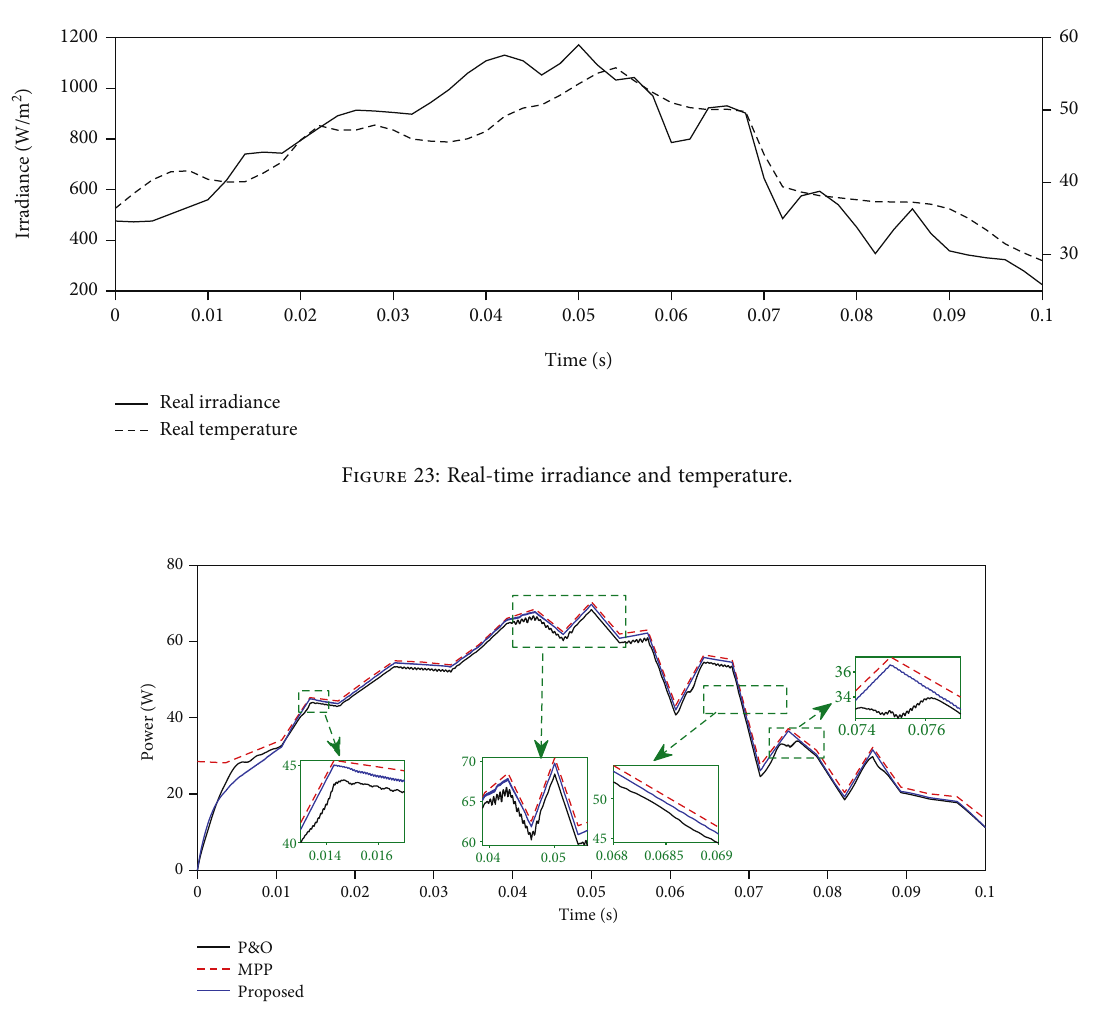
Figure 24: Tracking of the real-time condition maximum power with the P&O and the enhanced MPPT algorithm.